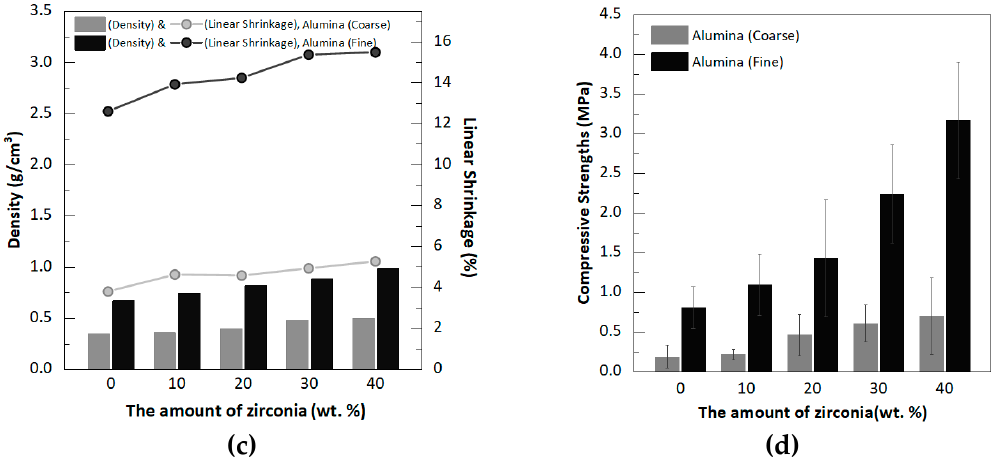
Figure 5. (a) Viscosities at a shear rate of 0.01 s − 1 of the ZTA slurries, (b) compressive strengths of Figure 5. ( a ) Viscosities at a shear rate of 0.01 s − 1 of the ZTA slurries, ( b ) compressive strengths of reticulated porous ZTA reticulated porous ZTA (c) densities and linear shrinkage rates, and (d) X-ray diffraction patterns ( c ) densities and linear shrinkage rates, and ( d ) X-ray diffraction patterns of reticulated porous ZTA with different amounts of reticulated porous ZTA with different amounts of zirconia added . of zirconia